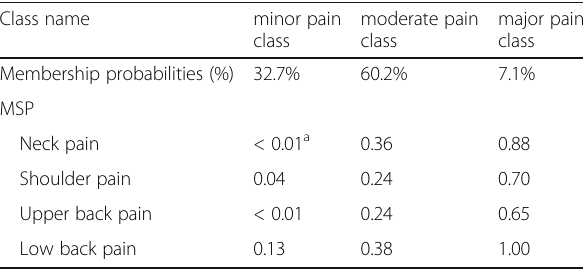
Table 2 Membership and item response probabilities in general